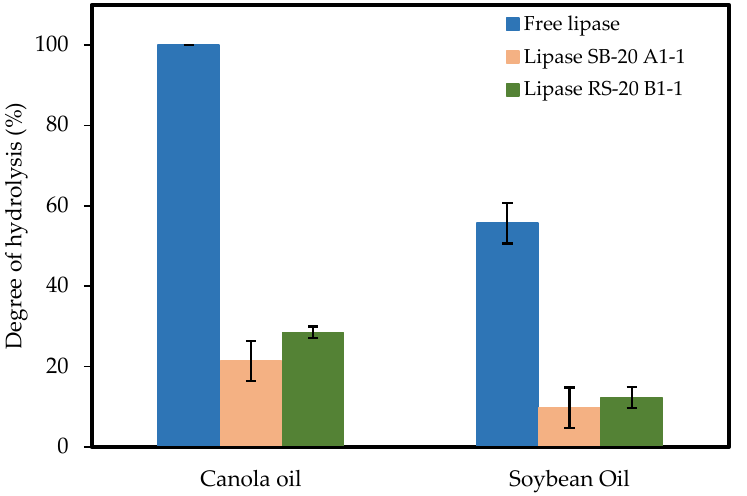
greater activity than immobilized enzymes (lipase SB ‐ 20 A1 ‐ 1 and RS ‐ 20 B1 ‐ 1), both for